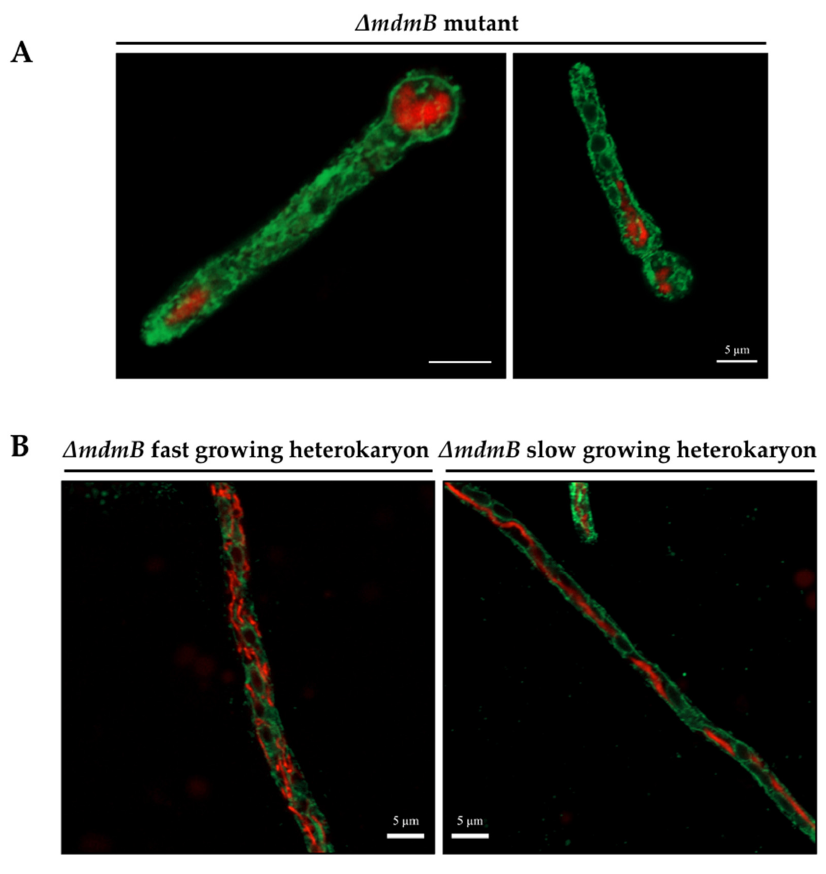
Figure 9. MdmB is required for mitochondrial division. ( A ) Spores from Δ mdmB heterokaryon HVG2 were plated on selective media at 37 °C by 21 h. Then, the conidia were fixed and observed using Airyscan microscopy. ( B ) Fast-growing and slow-growing mycelial sectors, obtained from a Δ mdmB HVG2 heterokaryotic colony grown on selective media for 5 days, were fixed and observed using confocal microscopy. The red and green signals correspond to mitochondria labelled with mCherry and ER labelled with GFP, respectively. Scale bar = 5 µm. Using the same approach, we asked whether MdmB was necessary to induce the mi- tochondrial constrictions elicited by H 2 O 2 . In vivo experiments using hyphae from Δ mdmB slow-growing heterokaryotic sectors with tubular mitochondria (Figure 10A) showed that the mitochondria and the ER filamentous form remained virtually unchanged for the ob- servation period (0–324 s). When these sectors were exposed to H 2 O 2 , the mitochondria preserved most of their filamentous form, and only two incipient constrictions were ob- served between 202 and 243 s at putative mitochondria–ER contact points (Figure 10B). Similarly, CCCP was also largely ineffective to induce mitochondrial constrictions in tub- ular mitochondria from Δ mdmB slow-growing heterokaryotic sectors (Figure S9). These results reveal that MdmB is necessary for the development of mitochondrial constrictions induced by either H 2 O 2 or CCCP. All of the long mitochondrial filaments observed in Δ mdmB hyphae from slow grow- ing heterokaryotic sectors were found to accumulate ROS when stained with the super- oxide reporter MitoSox Red (Figure 11A), which is consistent with our previous results showing that the lack of mitochondrial division results in an increased production of mi-